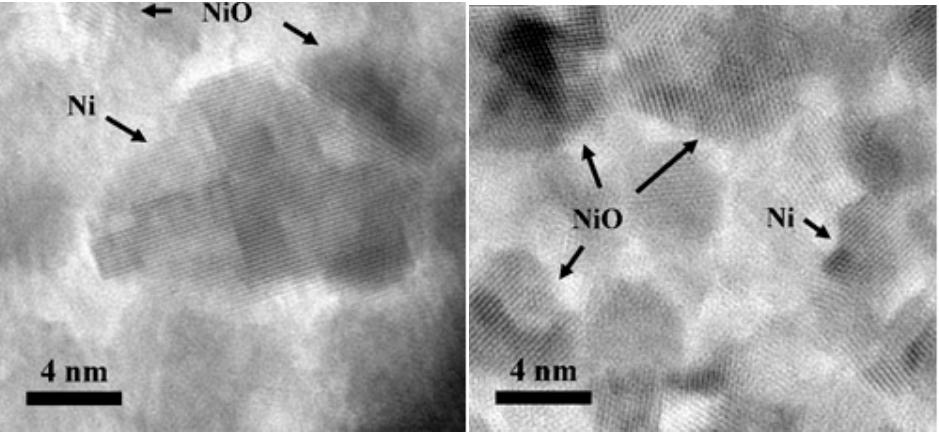
Figure 2. HRTEM images of larger and smaller Ni and NiO nanocrystals.